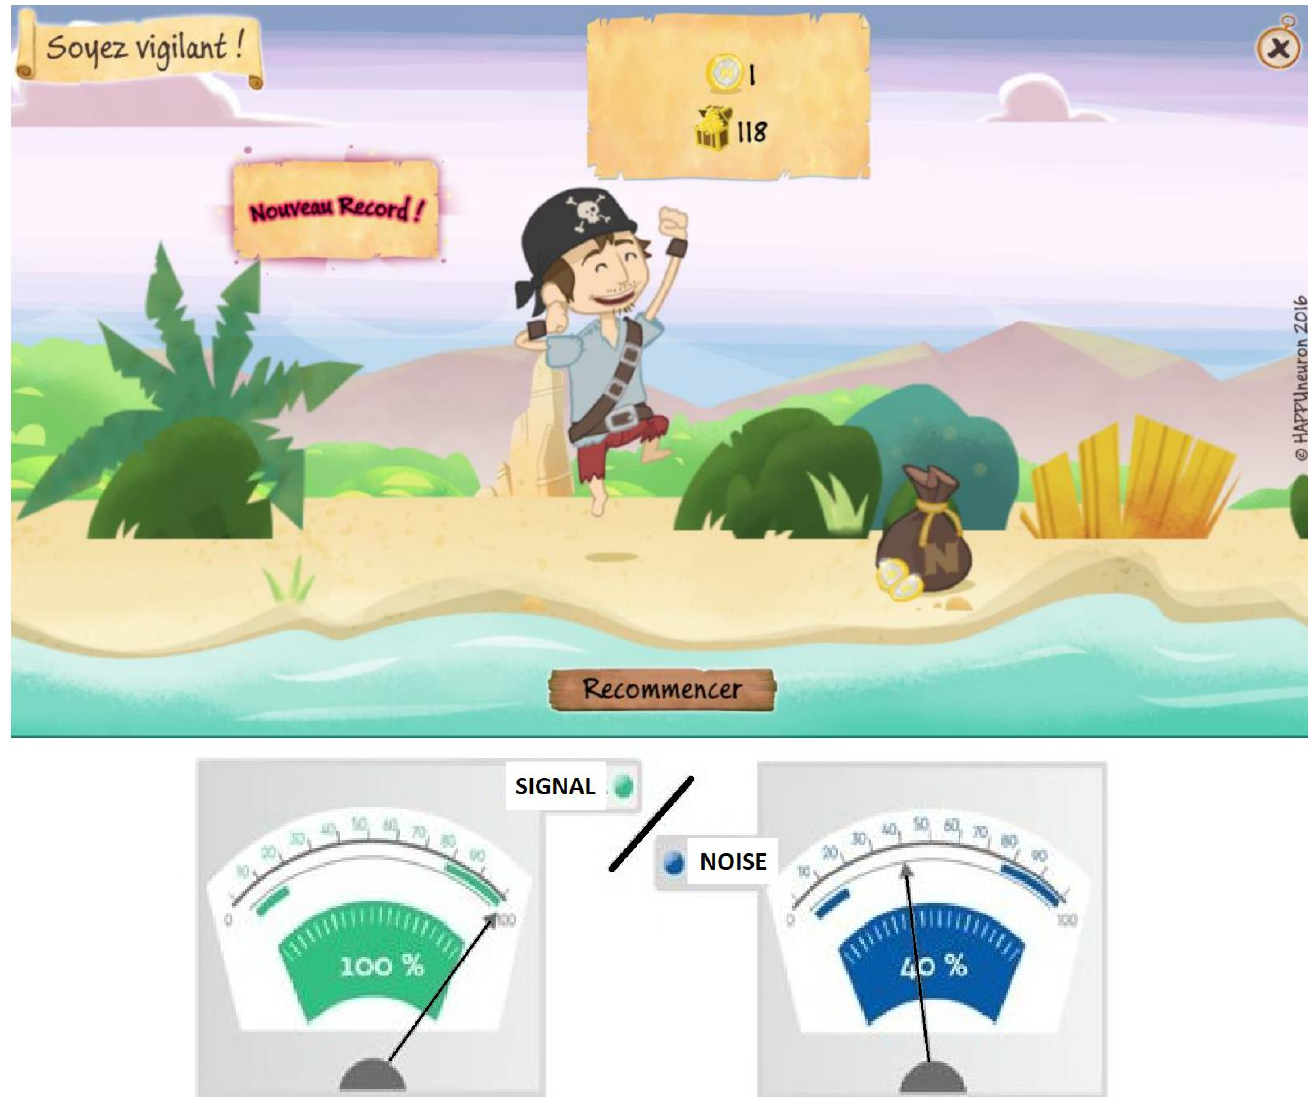
Figure 2. Serious game visuals with signal-to-noise ratio representation. As the player is detecting or identifying target sounds in the presence of background noise, the avatar is walking along a beach to collect coins. For each incorrect answer, the avatar falls and slightly regresses. After 4 incorrect answers or a pre-set time has elapsed, the game stops. The player is expected to collect as many coins as possible in 1 game with an updated score available on the screen at the end of each game. This playful mechanism encourages the player to immediately play again in an attempt to beat his/her personal record.